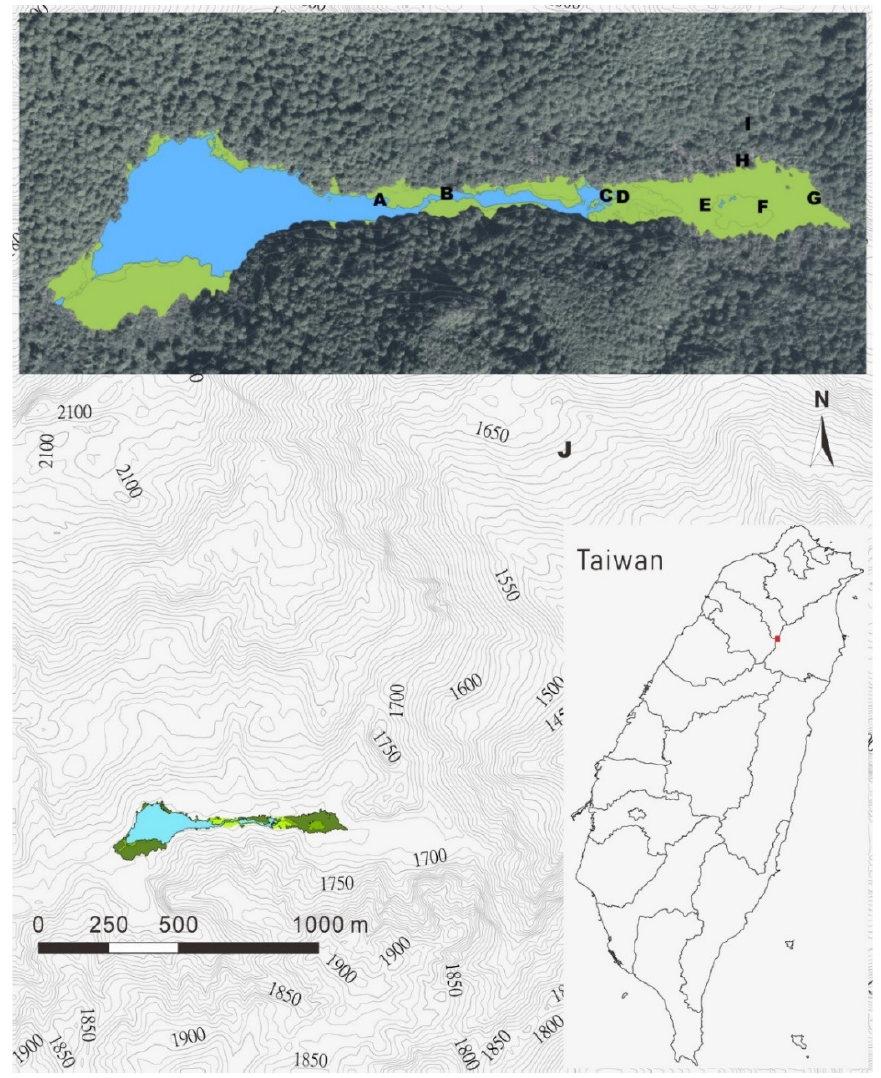
Figure 1. Location of the YYL site in northern Taiwan (red square). The delineated lake (in light blue) and peatland area (in green) surrounded by the aerial photograph of the old growth Chamaecy- paris obtusa var. formosana forest was the main study site where microbial community, as well as